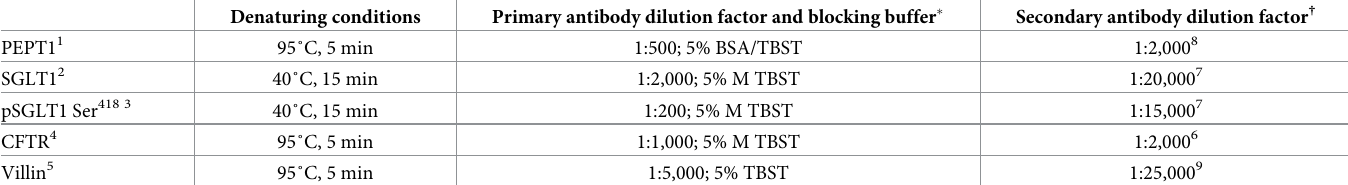
Table 2. Incubation conditions and dilution factors of the different antibodies used in the present study. Denaturing